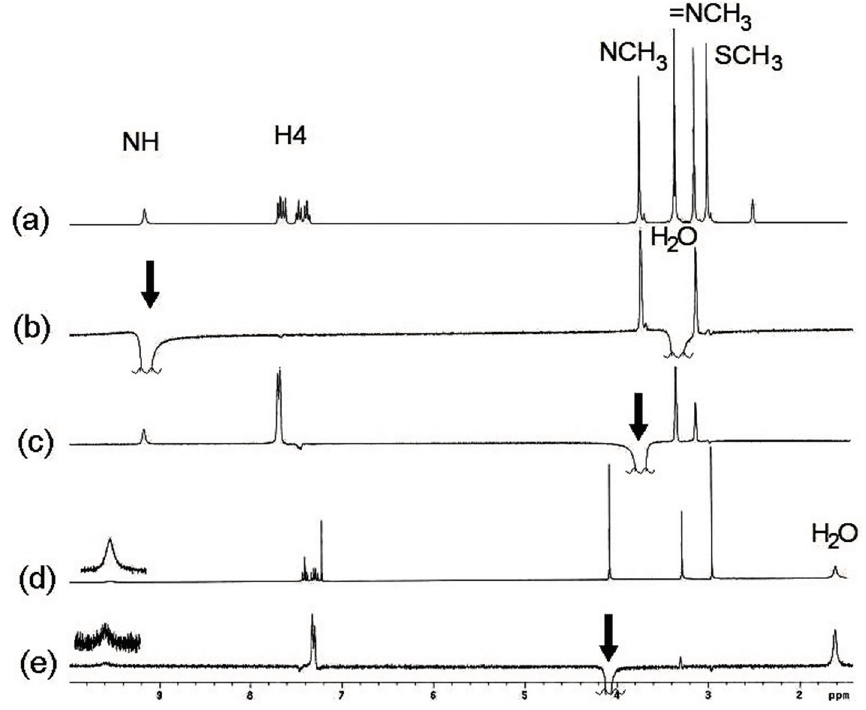
Figure 2. ( a ) 1 H-NMR spectrum of compound 11 in DMSO- d 6 ; ( b ) After irradiation of the NH signal, nOes on both CH 3 groups are observed; ( c ) nOe on the NH, exocyclic NCH 3